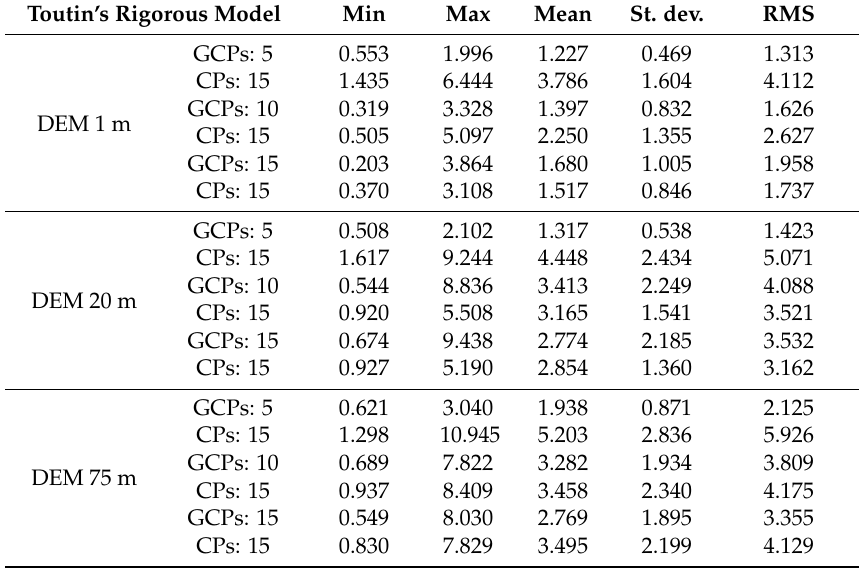
Table 6. Residuals (in meters) obtained for GCPs (5-10-15) and CPs using Toutin’s rigorous model. Toutin’s Rigorous Model Min Max Mean St.